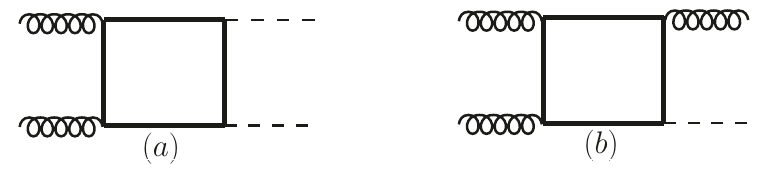
Figure 1 . Typical Feynman diagrams for (a) Higgs boson pair production and (b) Higgs boson production associated with a jet in the gluon-fusion channel at the leading